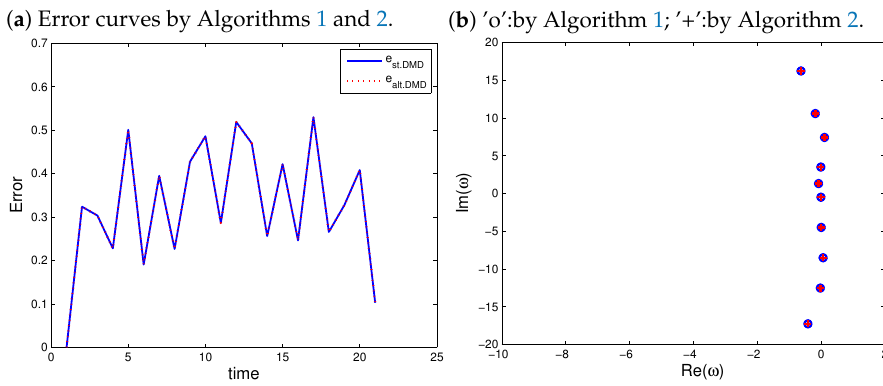
Figure 9. Relative errors ( a ) and DMD eigenvalues ( b ). Table 7. Execution time (in sec.) by Algorithms 1 and